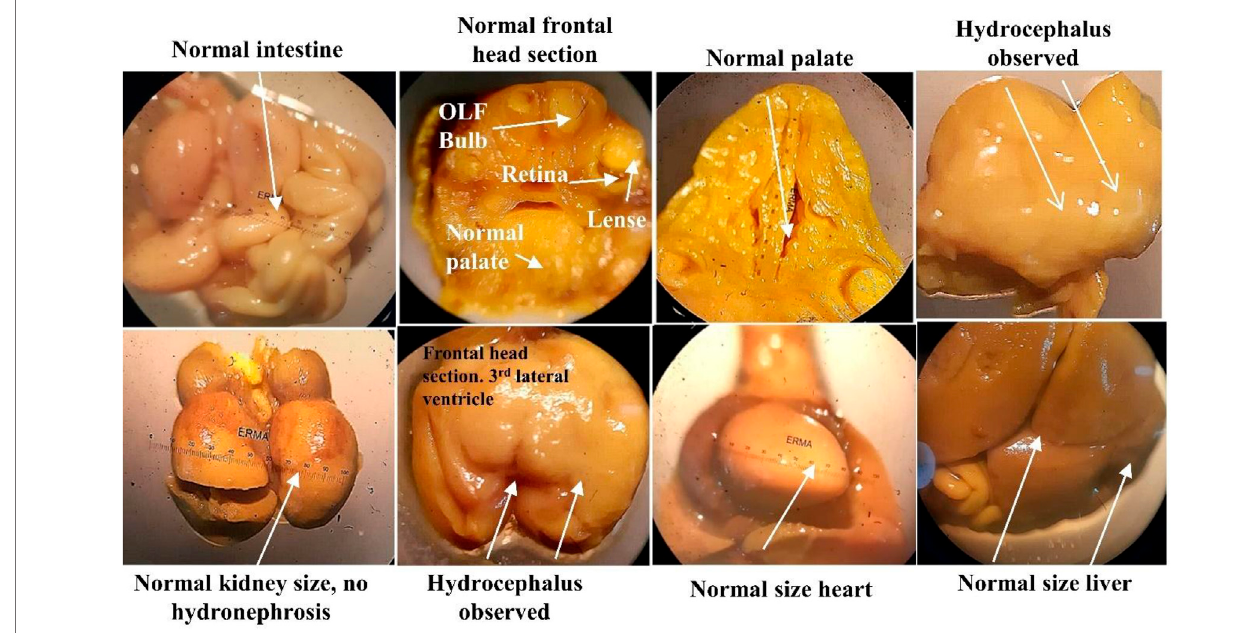
FIGURE 10 | Soft tissue examination of fetus through Bouin fi xation in the developmental toxicity study.